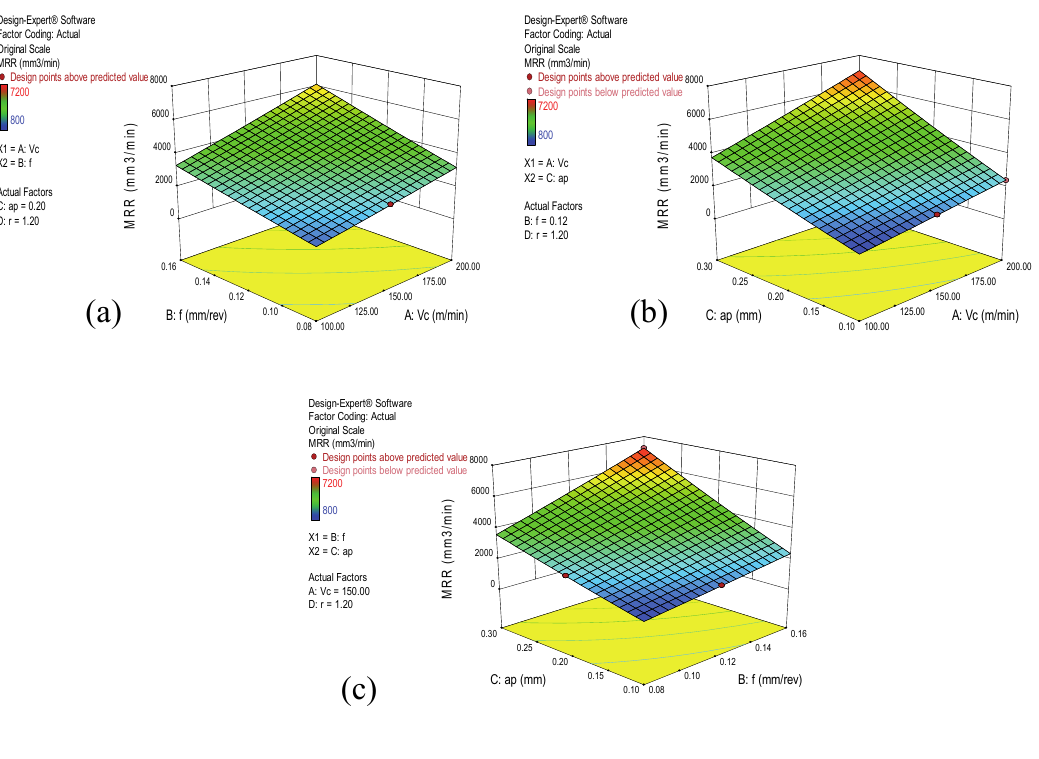
Fig. 10. 3D surface plot for MRR